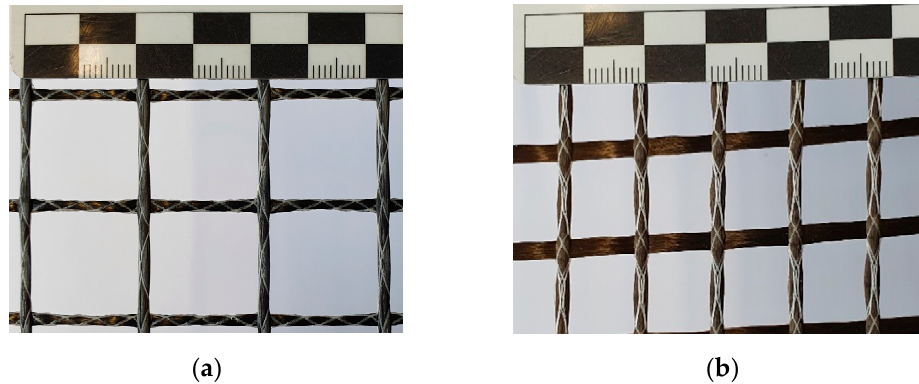
Figure 6. Geometry of the textiles used. ( a ) Carbon textile T 1C; ( b ) basalt textile T 2B. Table 2. Characteristics of the textiles (manufacturer data sheet [33] and own results). Name T 1C T 2B Fibre material Carbon